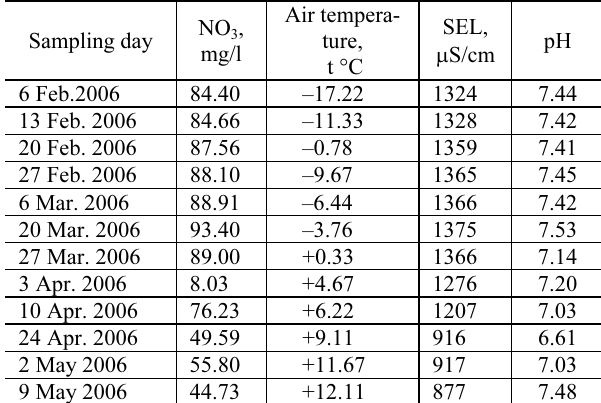
Table 1. Water quality data of investigated wells